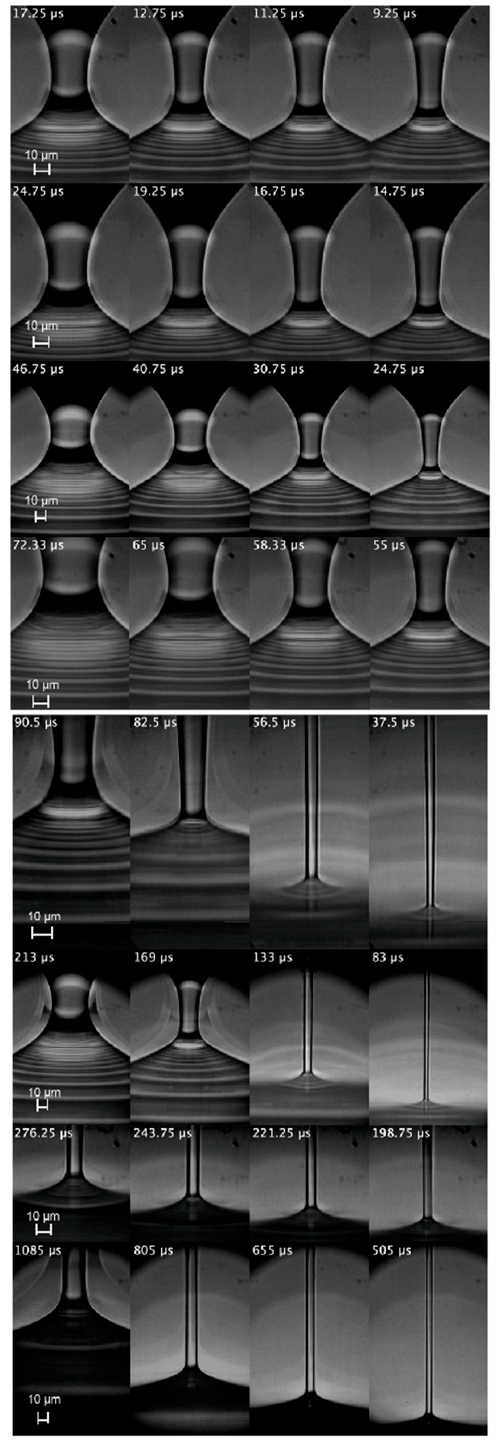
Figure 4 Figure 4. (From top to bottom) Images of the filament thinning over the elasto-capillary regime of PEO100K-0.01, PEO100K-0.05, PEO100K-0.1, PEO100K-0.2, PEO100K-0.5, PE100K-O1, PEO100K-2 and PEO100K-5. The labels indicate the time to the pinching. The white line separates the discarded realizations from those were the linear elasto-capillary regime was